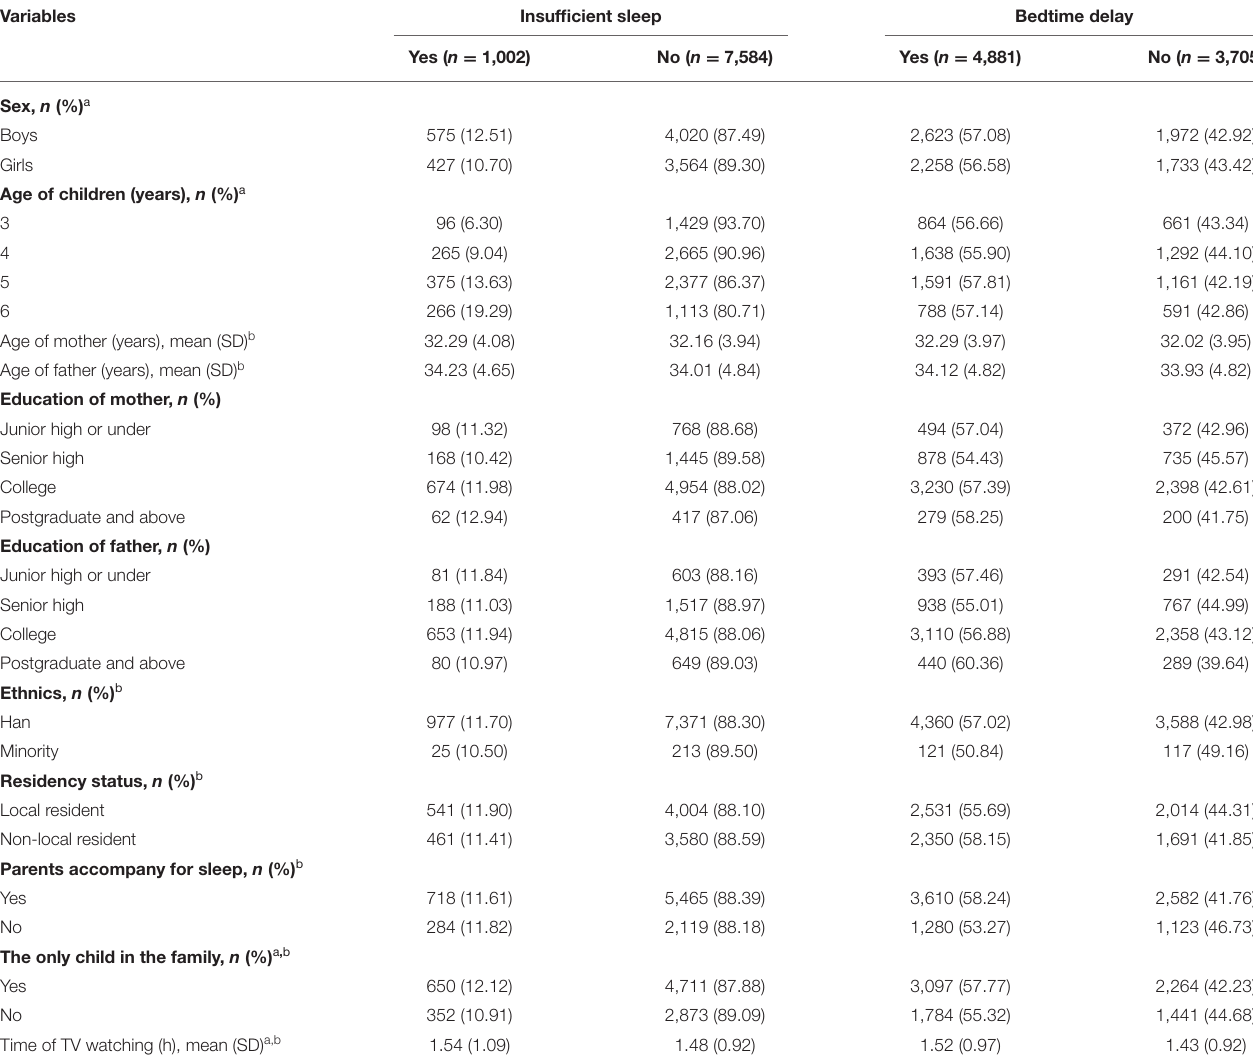
TABLE 2 | The prevalence of bedtime delay and insufficient sleep among children aged 3–6 years in a rural area of Shanghai, China, in the year